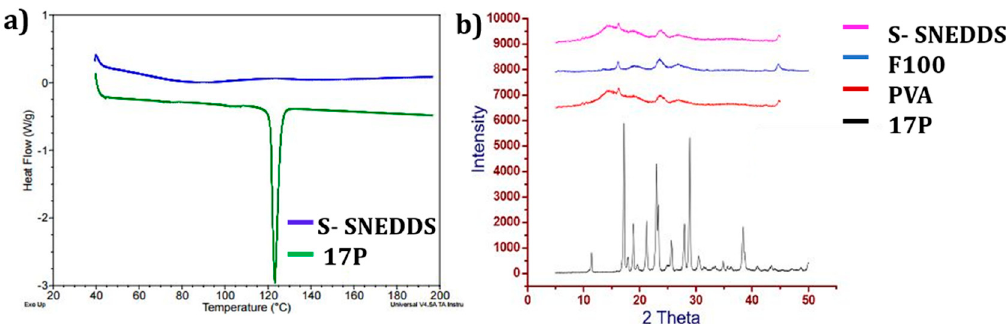
Figure 2. Solid state characterization of 17P and S-SNEDDS. ( a ) Differential scanning calorimetry (DSC) thermogram of 17P and S-SNEDD; ( b ) XRD of polyvinyl alcohol (PVA), F-100, 17P, S-SNEDDS. An absence of a sharp endothermic peak in DSC and a characteristic peak in XRD in S-SNEDDS confirmed that 17P remained in a solubilized state after adsorption of SNEDDS on PVA-F100.